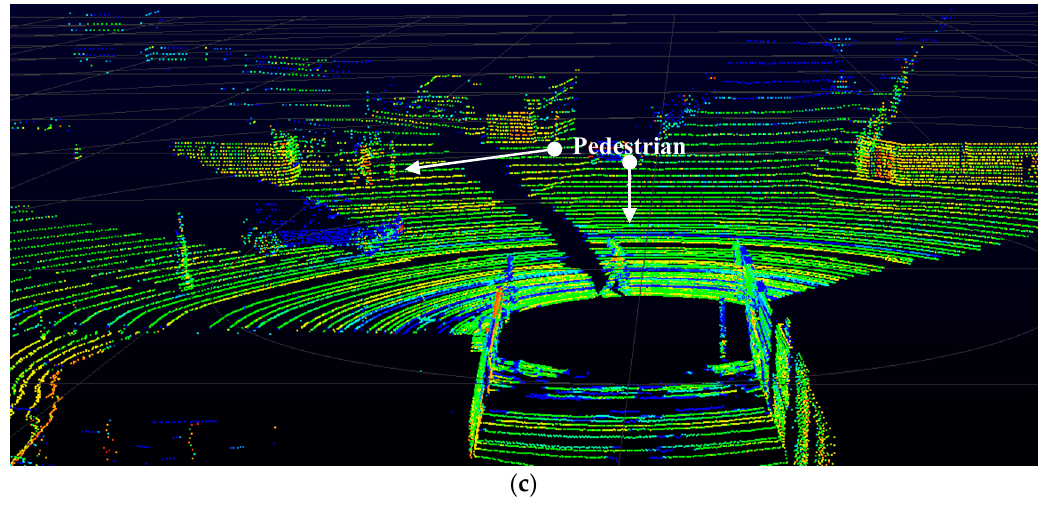
Figure 9. Three scene frames: ( a ) Intelligent Vehicles and Computer Vision Lab; ( b ) underground parking; ( c ) Real traffic scene. The colour of the points in the images represents the reflexivity value reported by the 3D LIDAR.